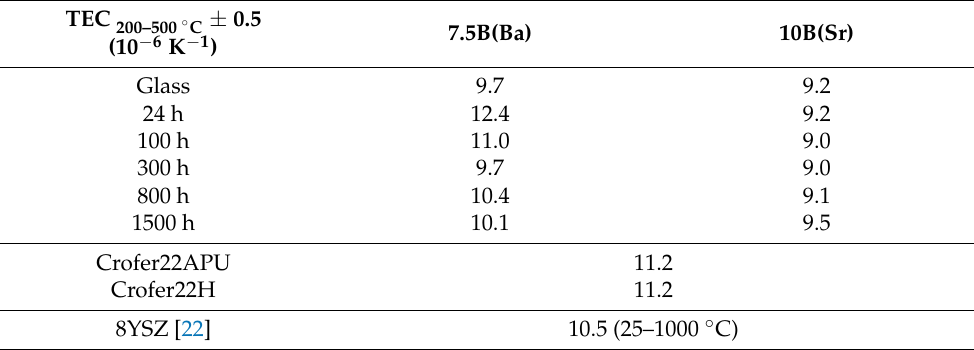
Table 7. Thermal expansion coefficient of the studied glass-ceramics.